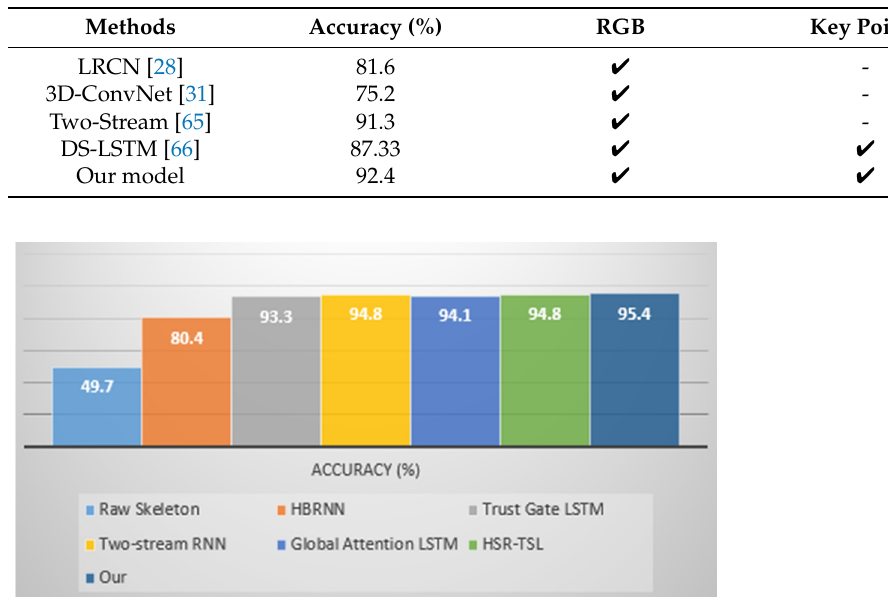
Figure 7. Accuracy comparison with other methods using the SUB Kinetic Interaction dataset.